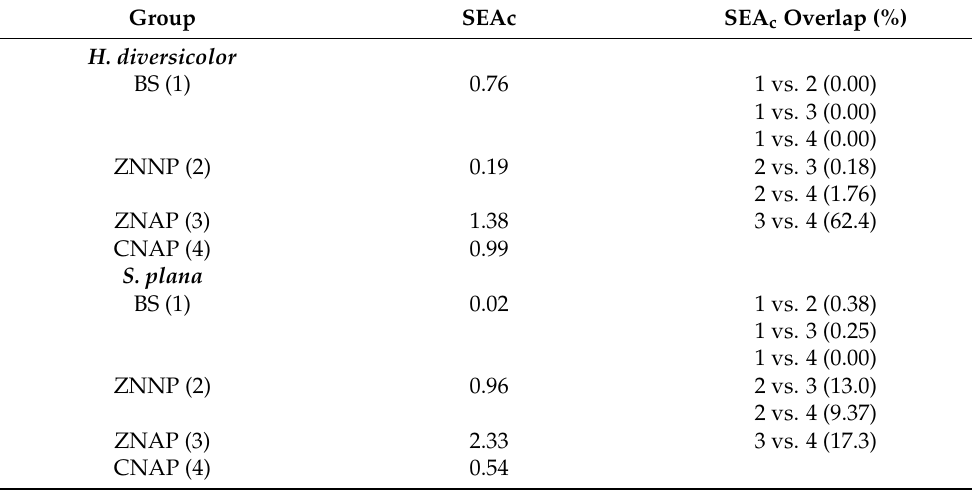
Table 4. Trophic niche width (SEAc) and overlap (SEAc overlap in %) estimated by SIBER analysis (Stable Isotope Bayesian Ellipses in R) for Scrobicularia plana and Hediste diversicolor in the different experimental treatments. SEAc, corrected standard ellipse area. BS, bare sediment; ZNAP, artificial patches of Zostera noltei; CNAP, artificial patches of Cymodocea nodosa; and ZNNP, natural patches of Z.